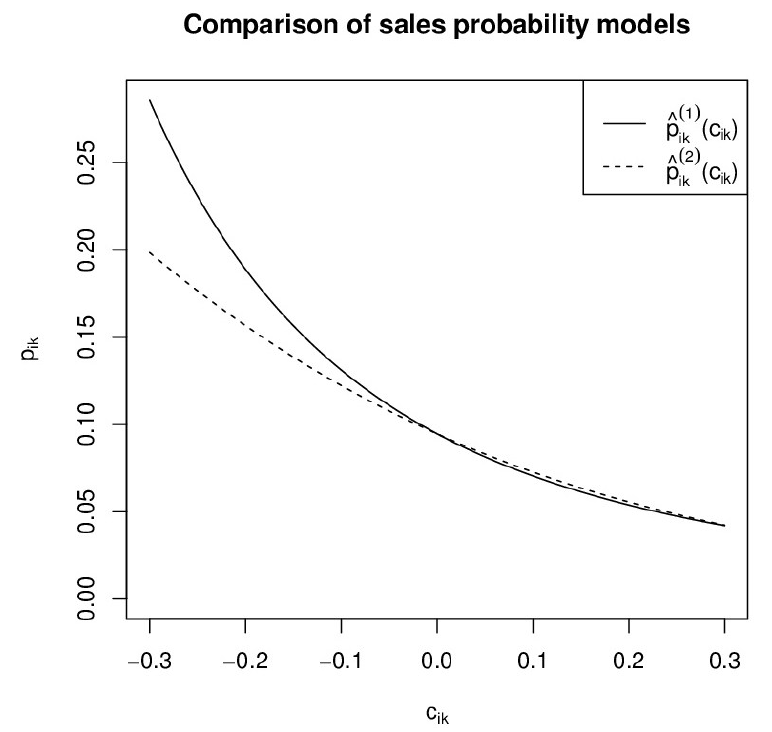
  1 ˆ p for different values of the p and   2 ˆ ( 1 ) ( 2 ) ik ik and ˆ p for different values of the price ik ik c . ik